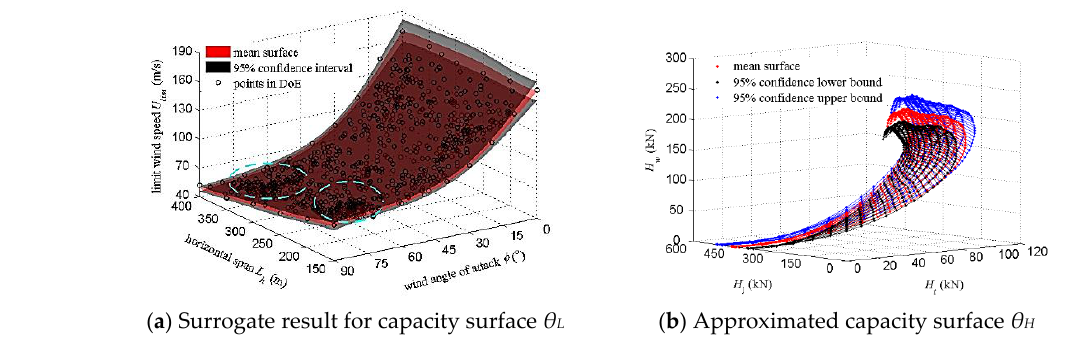
Figure 9. The surrogate result for capacity surfaces.